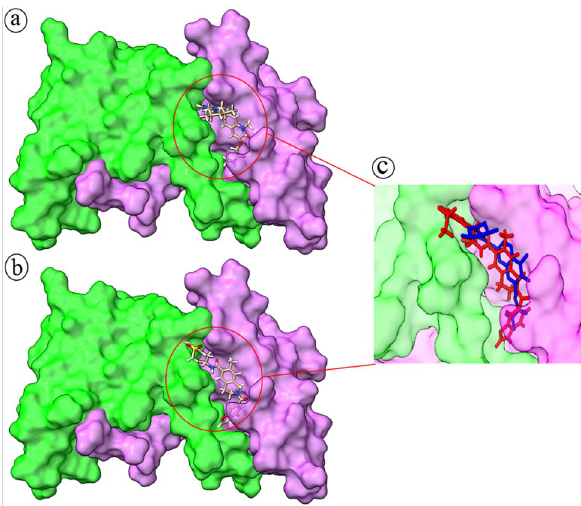
Figure 5. The interaction orientation for BI-3802 ( a ) and Lifitegrast ( b ) with the BCL6 protein. Chain A of the BLC6 is green and chain B is violet. Simultaneous occupation of the interaction site ( c ) by BI-3802 (blue) and Lifitegrast (red) shows their similar orientation within this site.